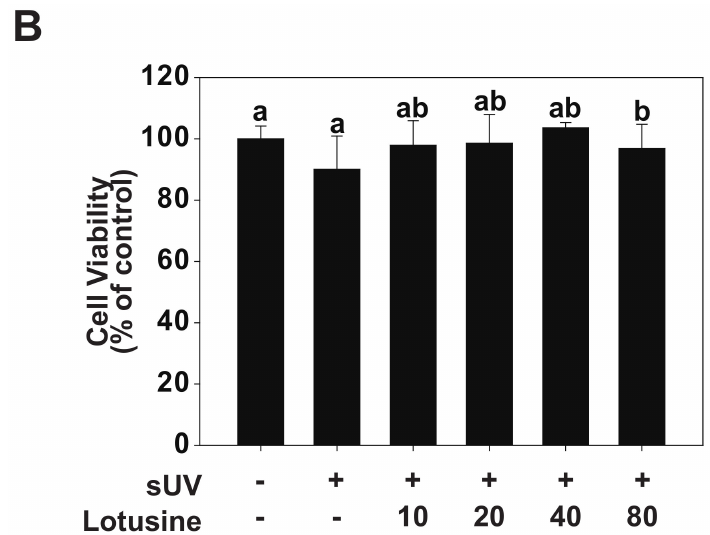
Figure 1. Effect of lotusine on HaCaT cell viability. ( A ) Chemical structure of lotusine. ( B ) MTT assay results showed that lotusine does not exhibit cytotoxicity up to a concentration of 80 µ M. Means with different letters (a,b) within a graph significantly differ from each other at p <